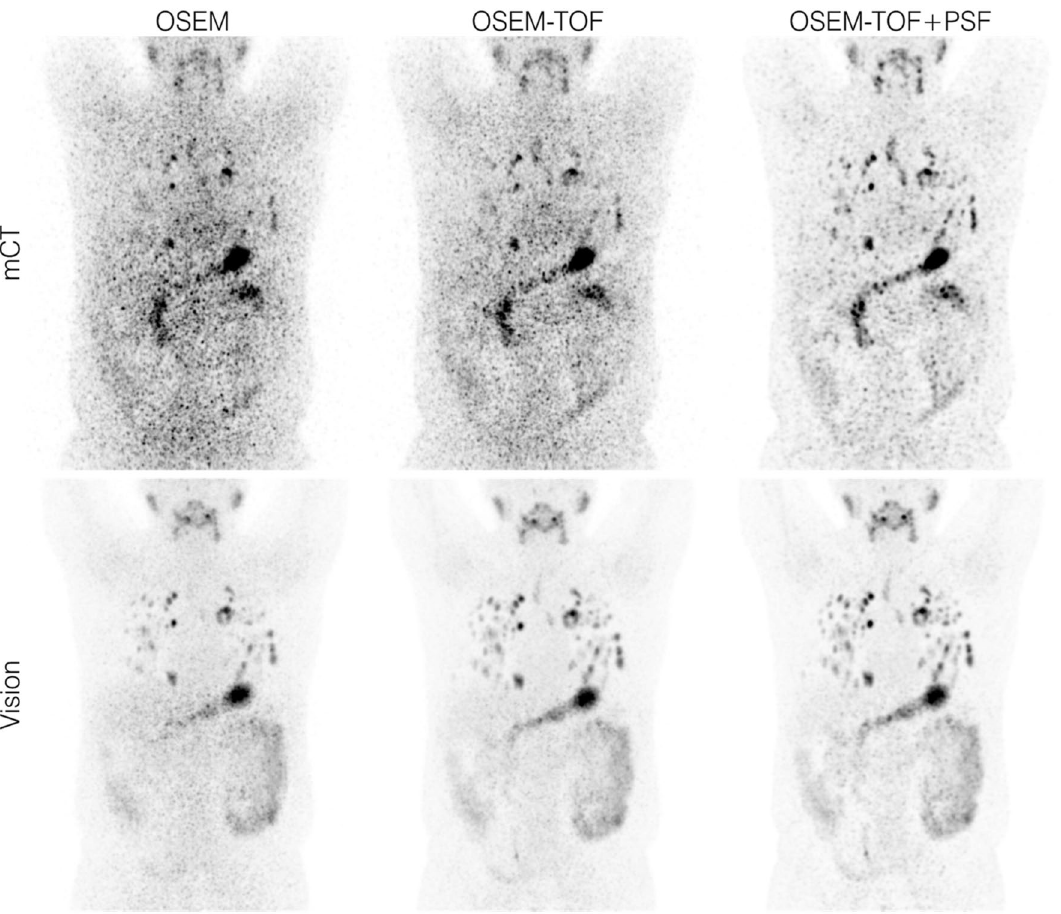
37.5 MBq of 124 I). The size range of the detected lung lesions was 4–24 mm in